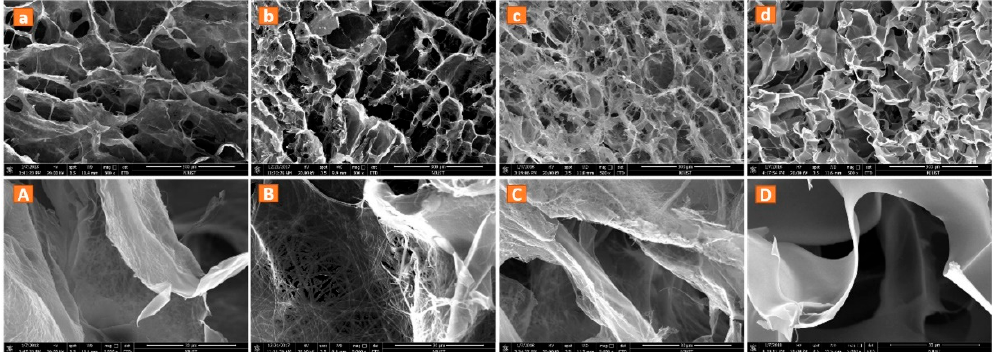
Figure 2. SEM images of the 3D nanofibrous scaffolds. ( a – d ) Scaffolds of 1%-0.5 mL, 1%-1 mL, 2%-1 mL, and 1%-0 mL at 500×. ( A – D ) Scaffolds of 1%-0.5 mL, 1%-1 mL, 2%-1 mL, and 1%-0 mL at 5000×. 500 × . ( A – D ) Scaffolds of 1%-0.5 mL, 1%-1 mL, 2%-1 mL, and 1%-0 mL at 5000 × .